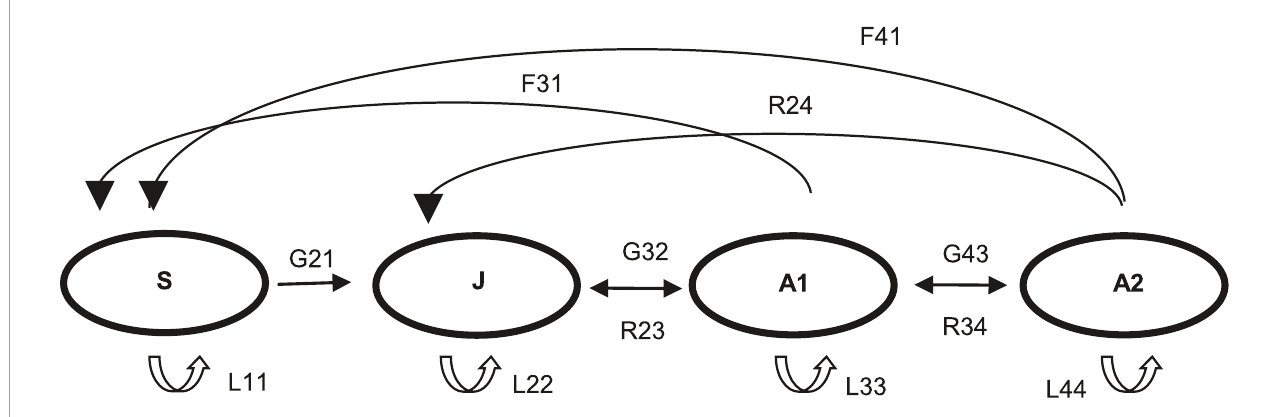
FIGURE2 Life cycle diagram of Rodriguezia granadensis . S, seedling; J, juvenile; A1, adult, stage 1; A2, adult, stage 2. Transitions: G, growth; F, fecundity; L, stasis in the same stage; R, reverse.